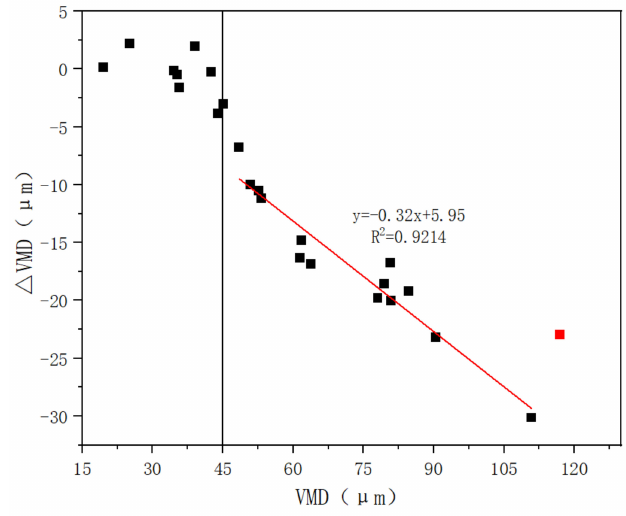
Figure 8. The relationship between the VMD when the applied voltage is 0 kV and the ∆ VMD when the applied voltage changes from 0 to 4 kV.